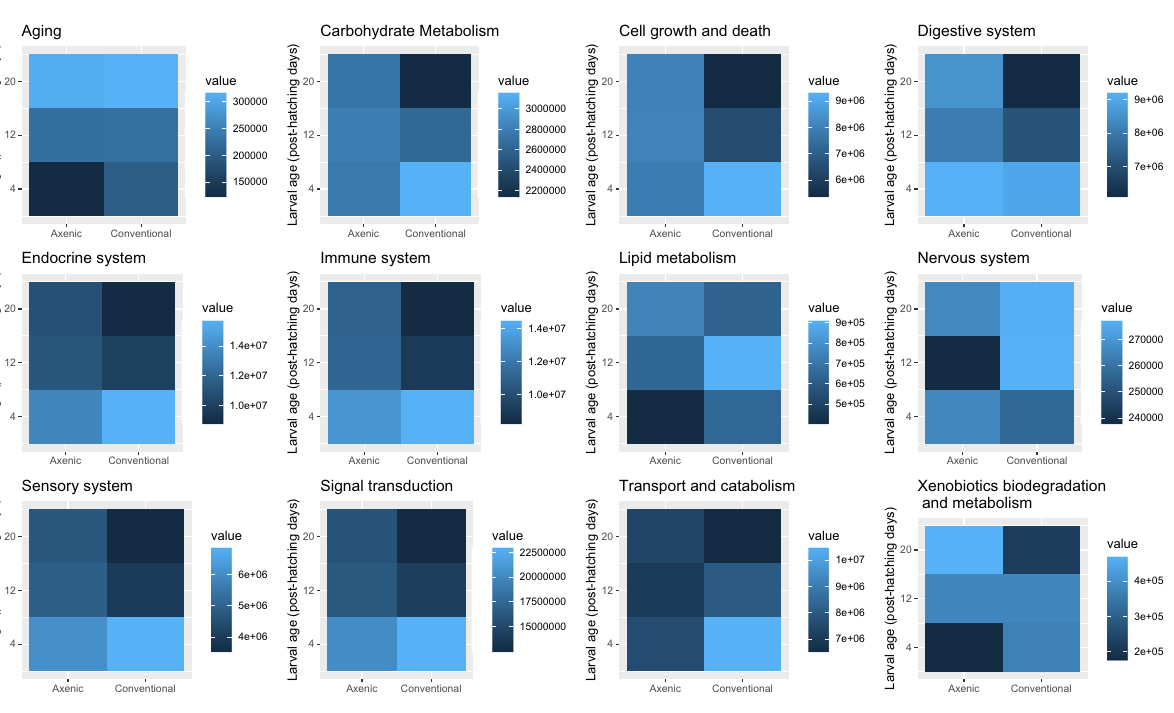
Figure 6. Enriched KEGG pathways in larvae reared in axenic and conventional condition. The value represents the total abundance of DETs associated with the specific pathway for the condition at each time